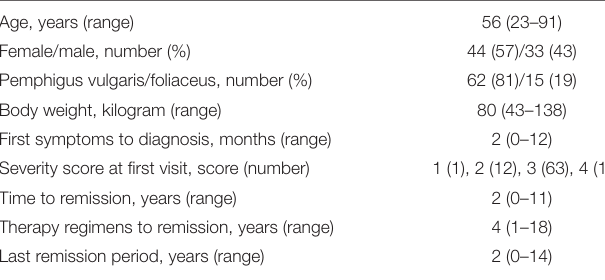
TABLE 1 | Patient characteristics ( n =